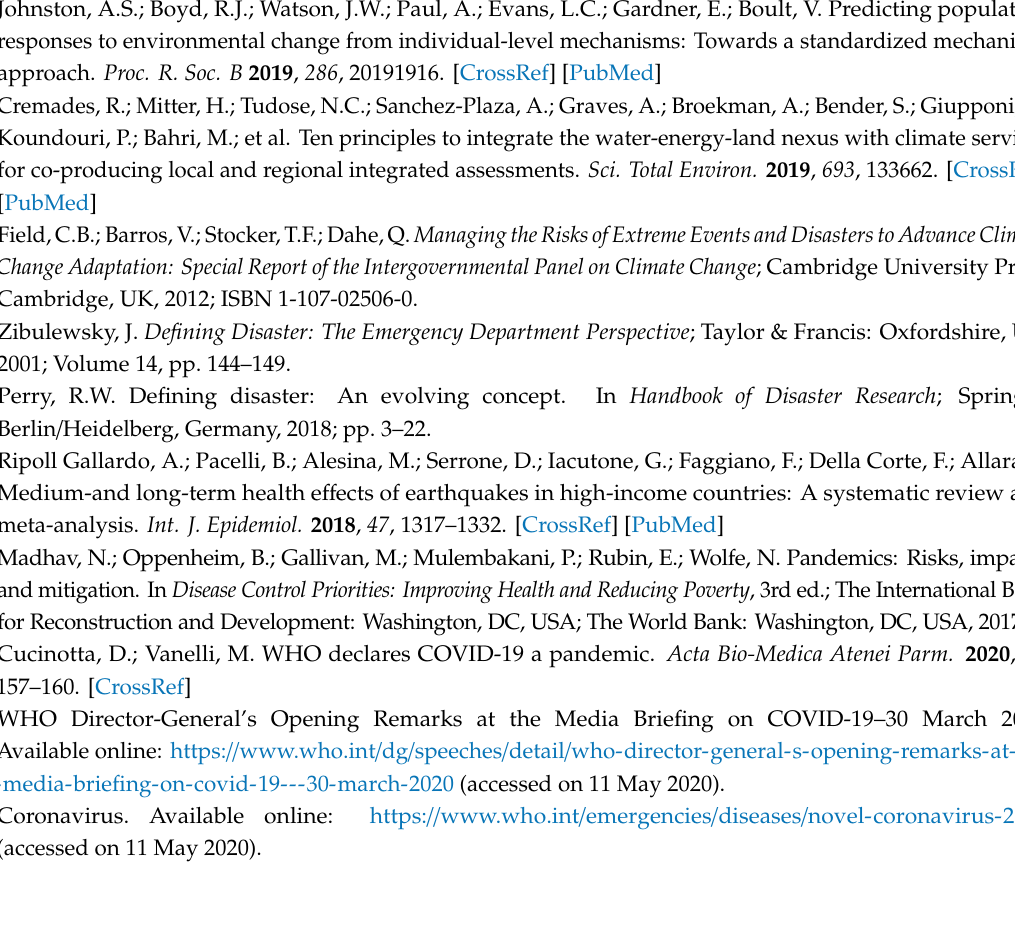
Figure S1: Average weekly NO 2 concentration between January 2019 and April 2020 in urban areas from Spain, France, United Kingdom, Italy, Austria and Poland. Source: https: // www.eea.europa.eu / themes / air / air-quality-a nd-covid19 /